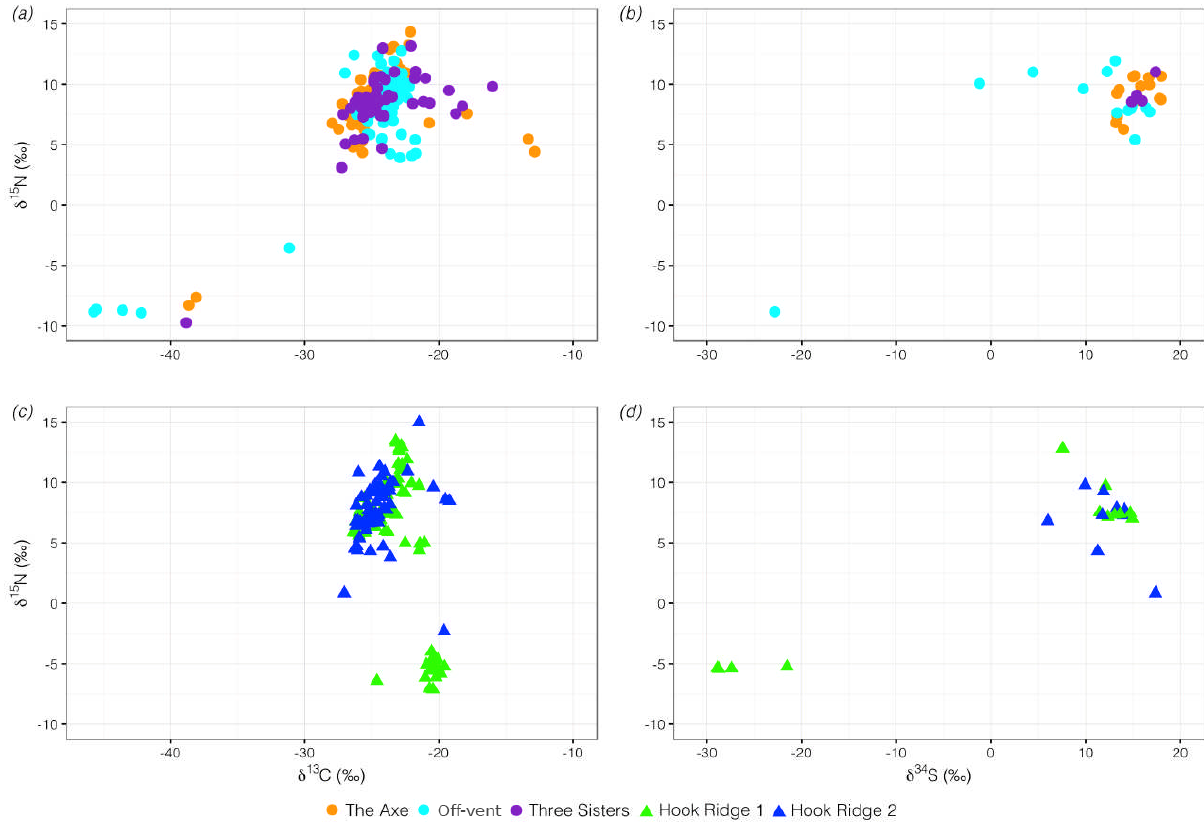
Figure 3. Carbon–nitrogen and sulfur–nitrogen biplots for bulk isotopic signatures of benthos separated into non-hydrothermal (a, b) and hydrothermal sites (c, d) . Except for one value from the off-vent site (for a peracarid species), all values with δ 15 N of <0 were siboglinid species ( Sclerolinum contortum from the hydrothermal sites and Siboglinum spp. from the non-hydrothermal